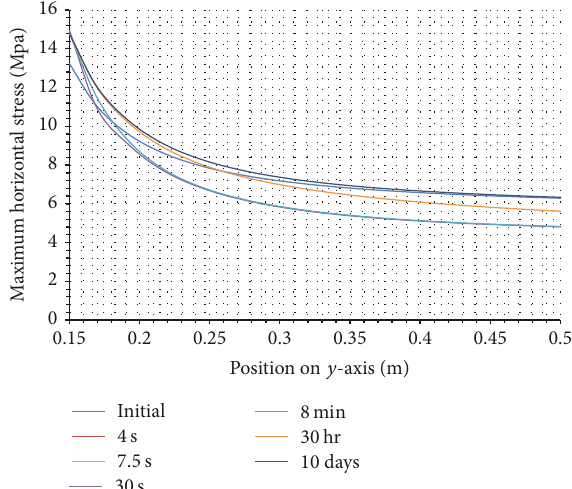
Figure 15: 𝑌 -component of net shear stresses as a function of time in poroelastic medium with 𝜎 𝐻 = 16.8MPa and 𝜎 ℎ = 14 MPa, 𝑃 𝑟 =